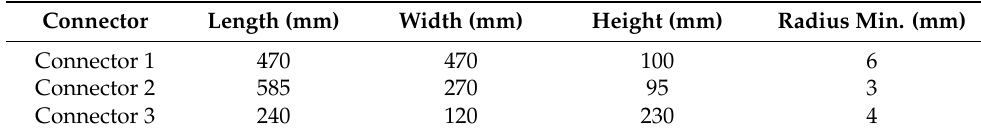
Figure 1. Geometry of connectors. Table 1. Geometrical dimensions of connectors. Table 1. Geometrical dimensions of